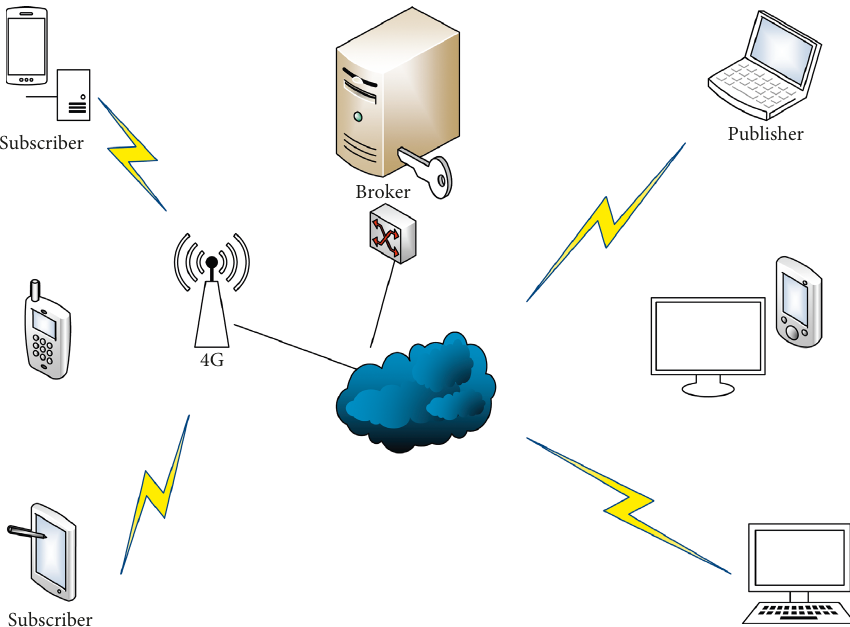
Figure 3: Architecture of the MQTT protocol.